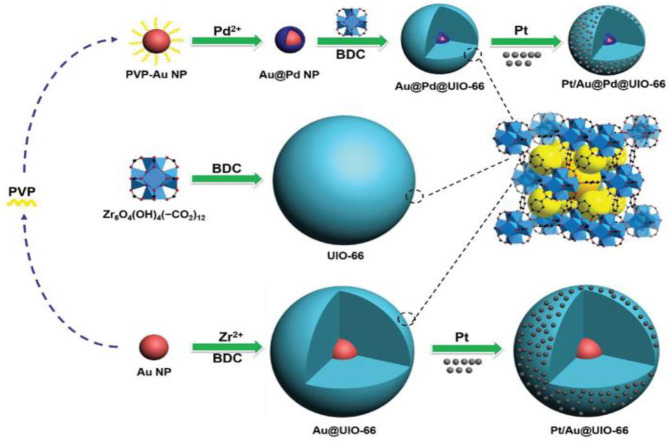
Synthetic route for the production of Au@Pd NPs and other nanocomposites. Reprinted with permission from Zheng et al. (2018). Copyright (2017) Wiley-VCH.